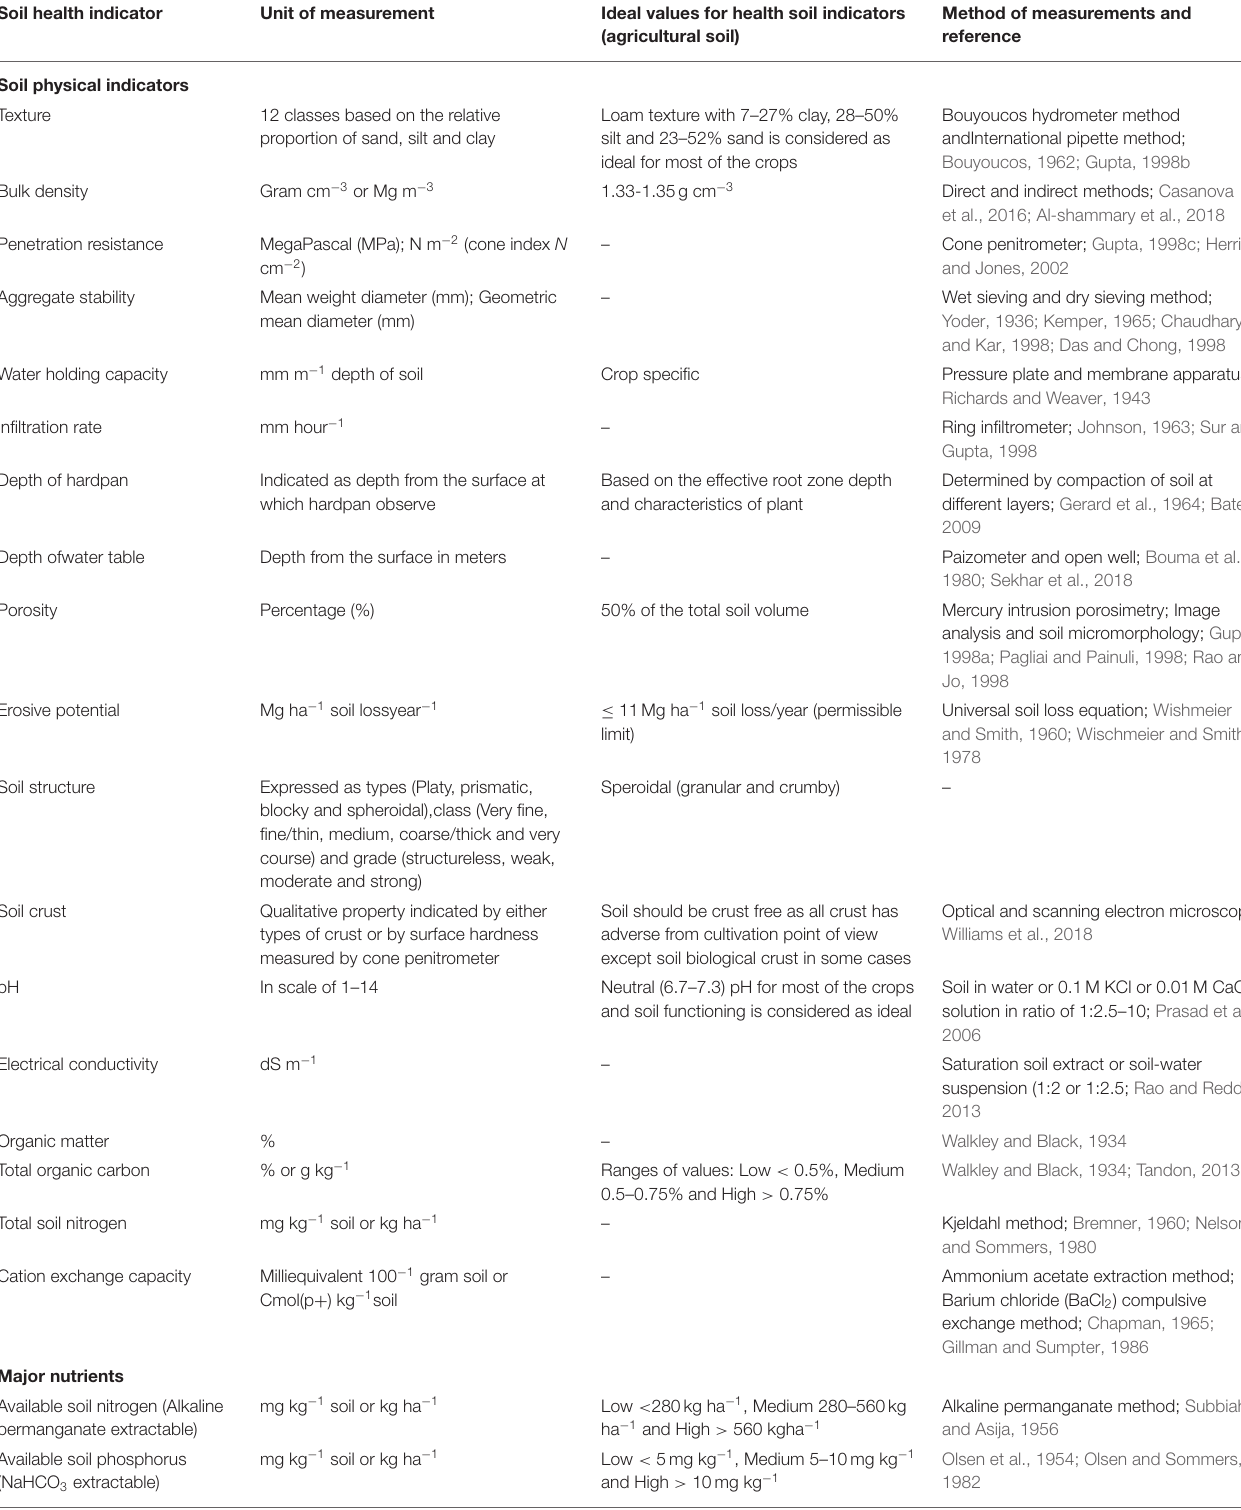
TABLE 3 | Soil health indicators and their